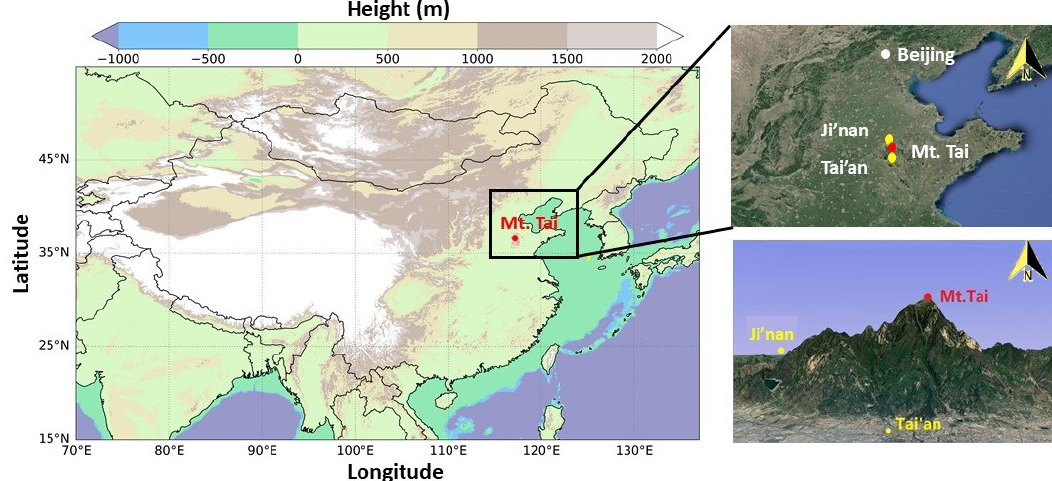
Figure 1. Maps showing the locations of Mt. Tai and the nearby cities. The left map is color-coded by the geographical height from the ETOPO1 Global Relief Model (https://www.ngdc.noaa.gov/mgg/global/, last access: 6 September 2020). The top-right map represents the North China Plain, and the bottom-right map is the 3-D shape of Mt. Tai with nearby urban regions. The maps on the right were obtained from © Google